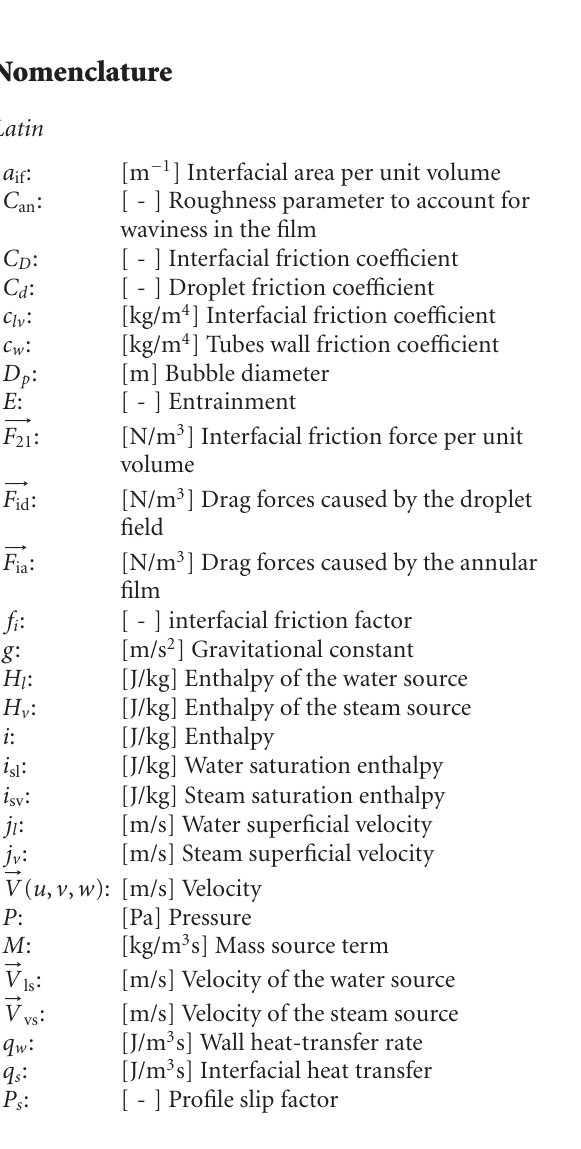
Figure 10: (a) Void fraction distribution in the calculations with the use of the model (5)–(17), (b) Void fraction distribution in the calculations with the use of the model